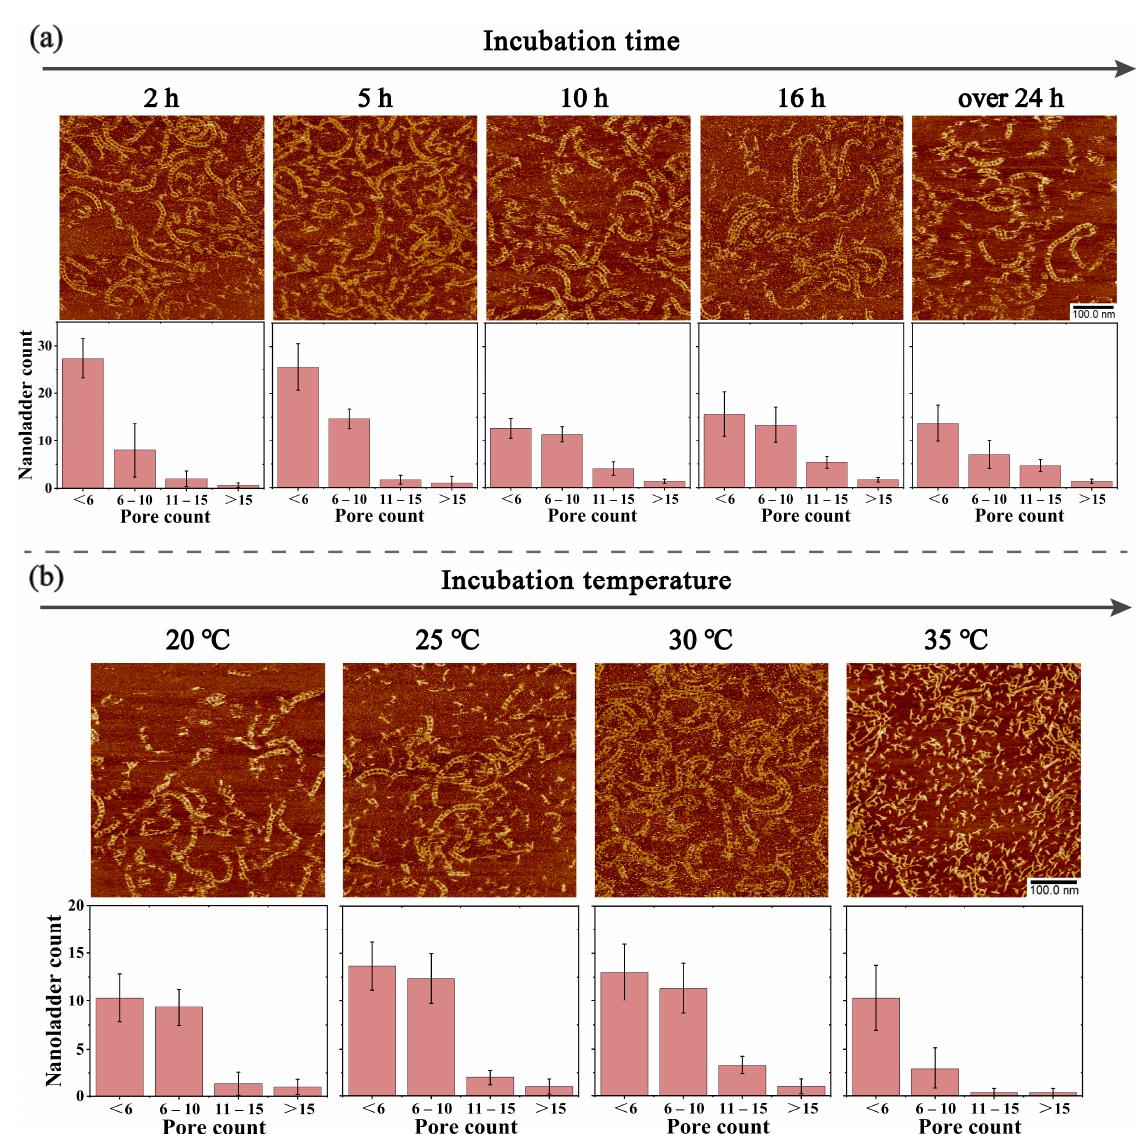
Figure 4. ( a ) AFM images and length statistics of DNA nanoladders at different incubation times. The lengths of nanoladders are divided into four groups (less than 6, 6 to 10, 11 to 15, and more than 15) according to the number of pores contained in the assembled structure. The x ‐ axis of the statis ‐ tical graph represents the groups, and the y ‐ axis represents the number of nanoladders. The number of nanoladders in each group is marked above the bars. The initiator and motif are reacted at a molar ratio of 1:10. All experiments are performed at room temperature (25 °C) for different incubation